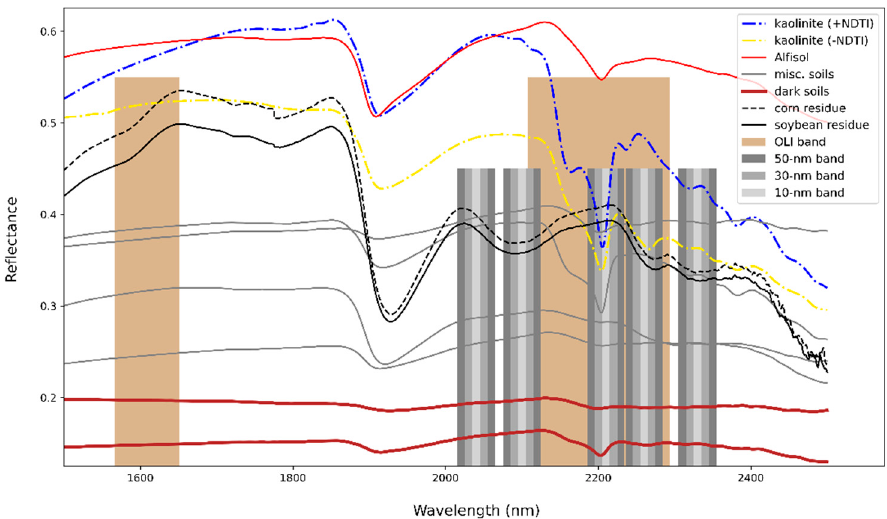
Figure 12. Example soil spectra with crop residue spectra for comparison. Note that some soils exhibit a 2200 nm reflectance decrease attributed to absorption by minerals such as montmorillonite, muscovite and illite, with variable absorption depending on soil type. The blue and yellow spectra represent kaolinite-rich soils, with a positive NDTI-fractional residue trend in blue, and a negative NDTI-fractional residue trend in yellow. Soils with overall low reflectance are noted as dark soils shown as thick brown lines. Crop residues are spectrally distinguished from soils based on a reflectance decrease from 2210 nm to 2260 nm associated with ligno-cellulose absorption. In contrast, soils show either consistent reflectance between these regions or minor reflectance increases as a function of wavelength.